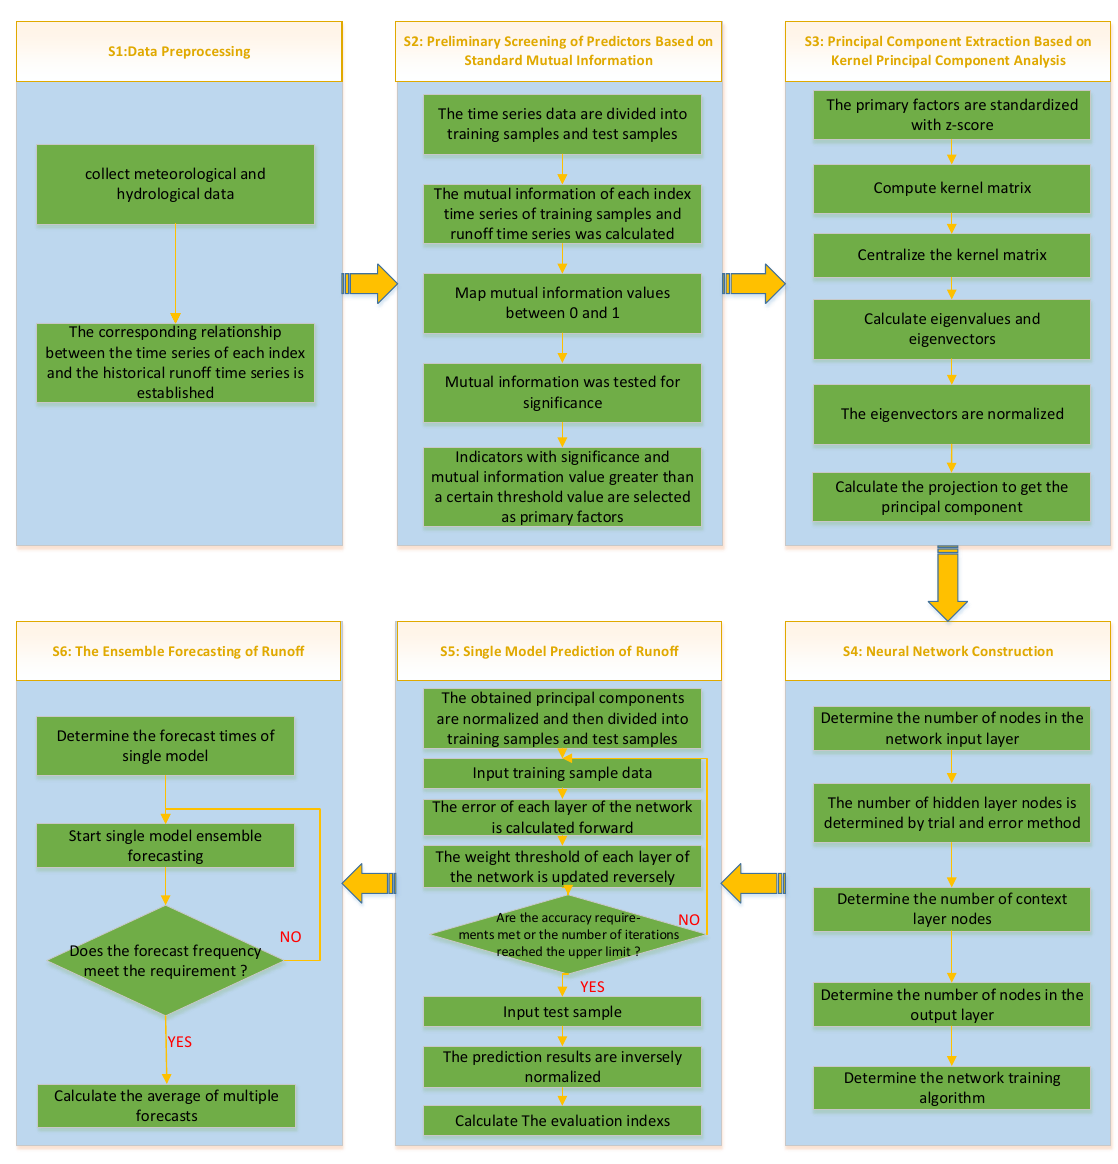
Figure 5. General method flow chart.